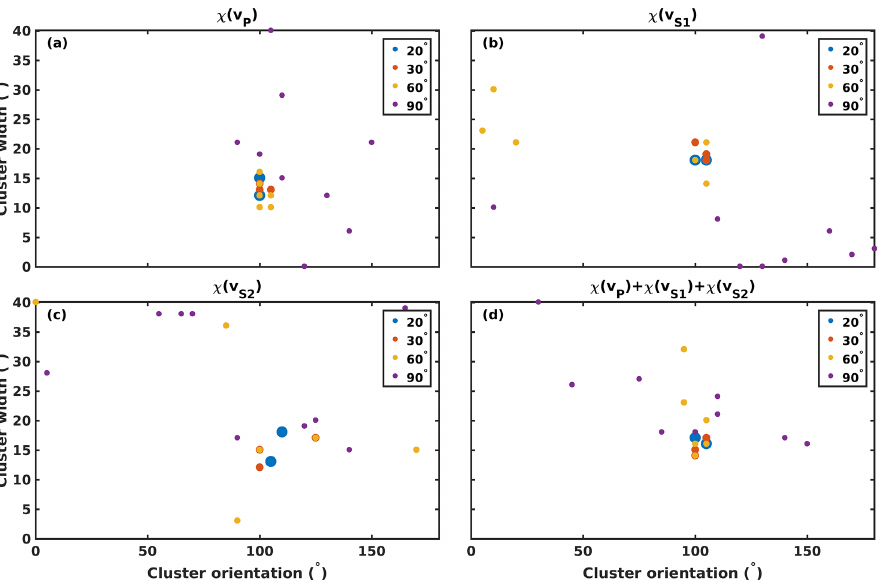
Figure 14. Parameter results using downsampled velocity measurements with azimuthal spacing of 20, 30, 60 and 90 ◦ (indicated by symbol size) for sample 003: (a) χ(v P ) , (b) χ(v S1 ) , (c) χ(v S2 ) and (d) χ(v P ) + χ(v S1 ) + χ(v S2 )